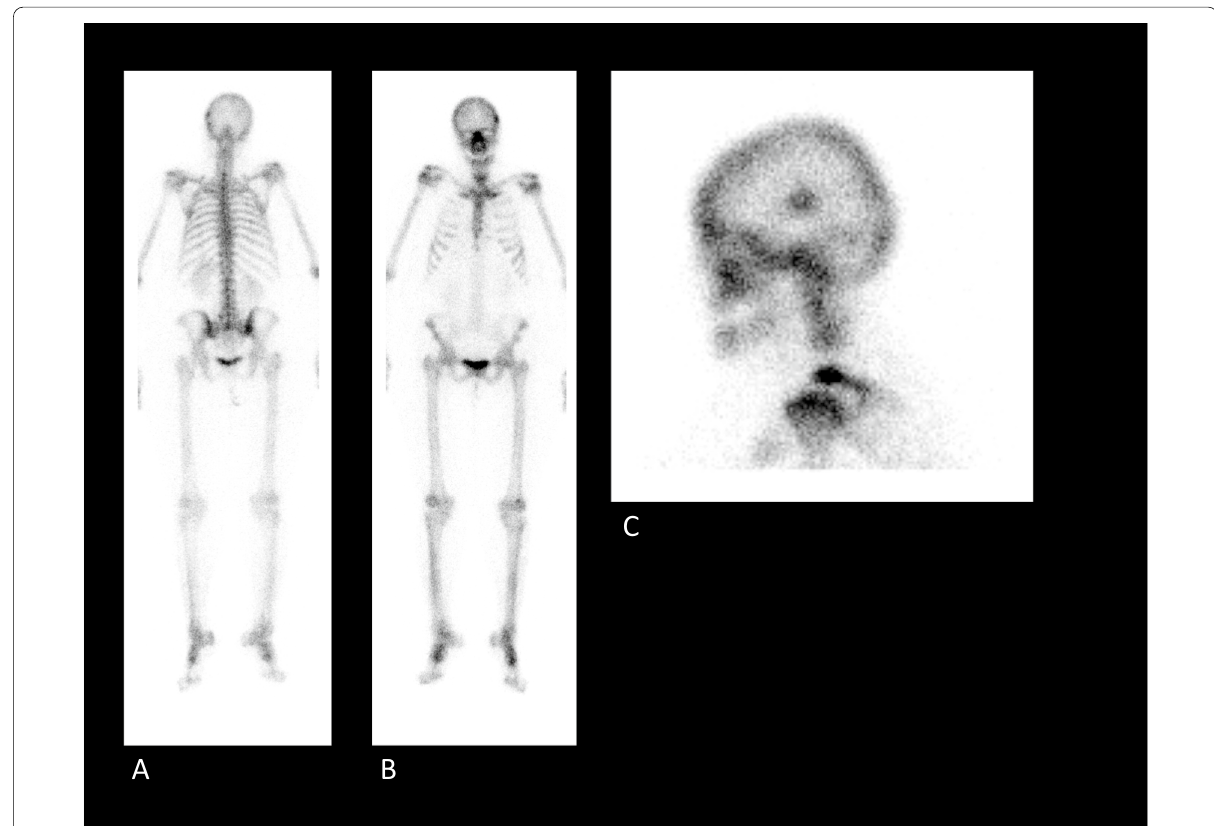
Fig. 5 Planar skeletal scintigraphy of an FBSS patient using technetium-99m hydroxydiphosphonate (Tc-99m HDP) to investigate rheumatological disease in the tarsal and metatarsal joints. A Posterior full-body planar image; B anterior full-body planar image; C Lateral skull planar image. Although Tc-99m HDP skeletal scintigraphy was carried out to assess the tarsal and metatarsal joints, full-body planar images were also acquired. In corroboration with the findings of Huang et al. [29], planar images show no specific features of FBSS. Findings were consistent with (nonspecific) degenerative changes in the spinal column and the bilateral tarsometatarsal joints. Focal round accumulation of tracer was observed in near the left parietal bone. This incidental finding was consistent with left parietal meningioma